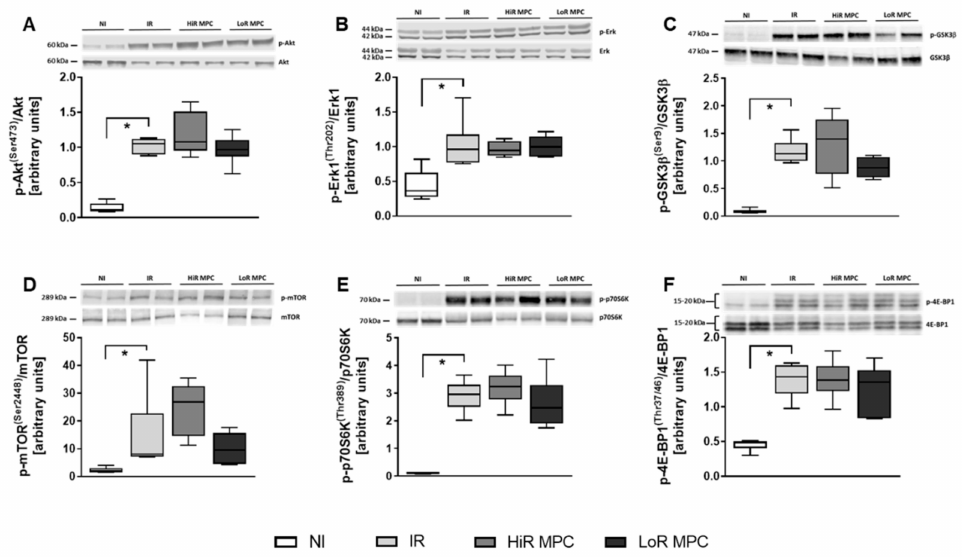
Figure 5. Activation of key signaling molecules—Reperfusion Injury Salvage Kinase (RISK) and mTOR pathway. Representative Western blots for phosphorylated and total proteins in top panels and ratios of phosphorylated to total proteins for: ( A ) Akt [Ser473]; ( B ) extracellular signal-regulated kinase 1 (Erk1) [Thr202]; ( C ) glycogen synthase kinase 3 beta (GSK3 β ) [Ser9]; ( D ) mammalian target of rapamycin (mTOR) [Ser2448]; ( E ) ribosomal protein S6 kinase (p70S6K) [Thr389]; ( F ) eukaryotic translation initiation factor 4E-binding protein 1 (4E-BP1) [Thr37 / 46]. HiR, high recovery; IR, ischemia reperfusion; LoR, low recovery; MPC, mechanical postconditioning; NI, no ischemia. Data are expressed as median, 25–75 percentiles and range. * p < 0.05 vs. IR ( n = 4–7 / group).